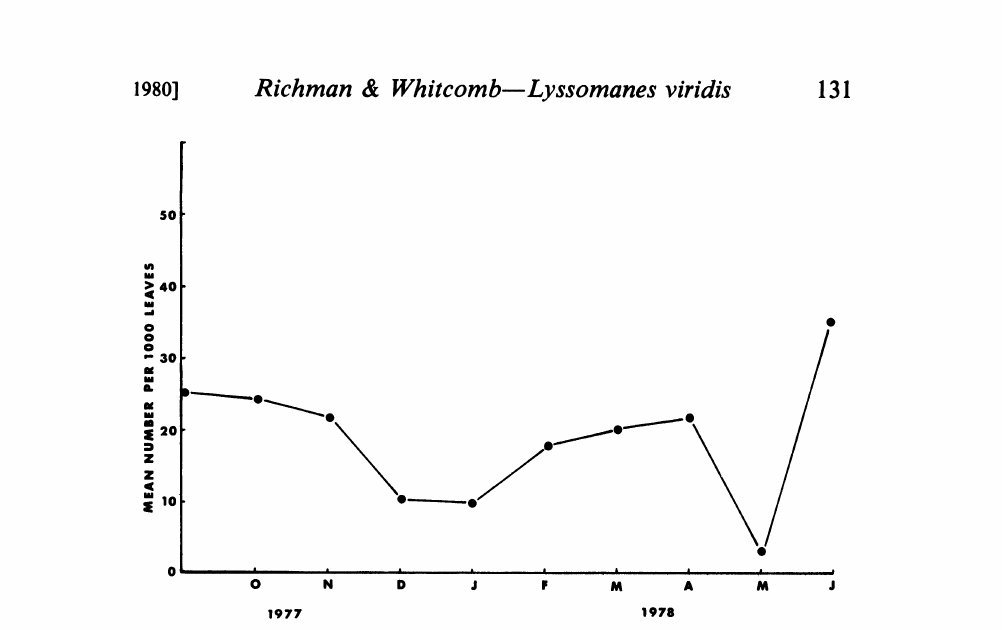
Figure 6. Population densities of Lyssomanes viridis (Walekenaer) in magnolia stand at Tall Timbers fall 1977 to spring 1978. Data points are means between surveys made both inside and outside the stand, during the last half of each